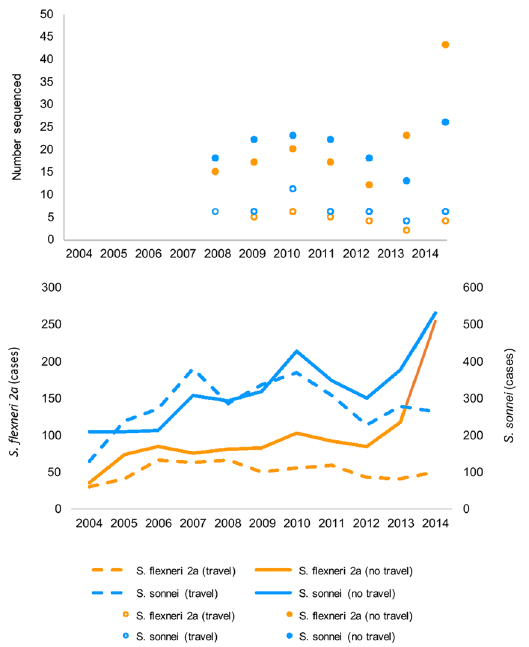
Figure 1. Representative sampling of isolates for whole genome sequencing. The figure shows a graph of the number of isolates sequenced per year by travel and species (upper graph), overlaid with the number of domestically-acquired (non-travel) and travel-associated cases of shigellosis (for all ages). Non-travel isolates were overrepresented (see